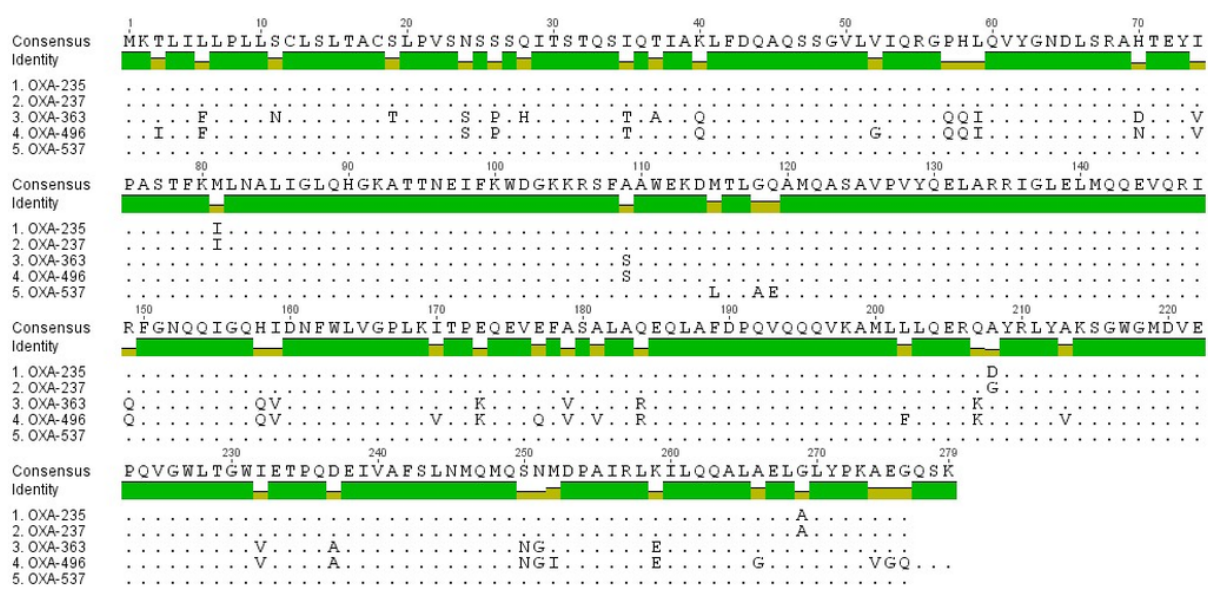
Fig. 1. Comparison of the amino acid sequences of the novel OXA-134-like variants (OXA-496 and -537), with the known OXA- 134-like enzymes (OXA-363, -235 and -237), using the Geneious multiple sequence alignment program. Differences are highlighted with black letters.